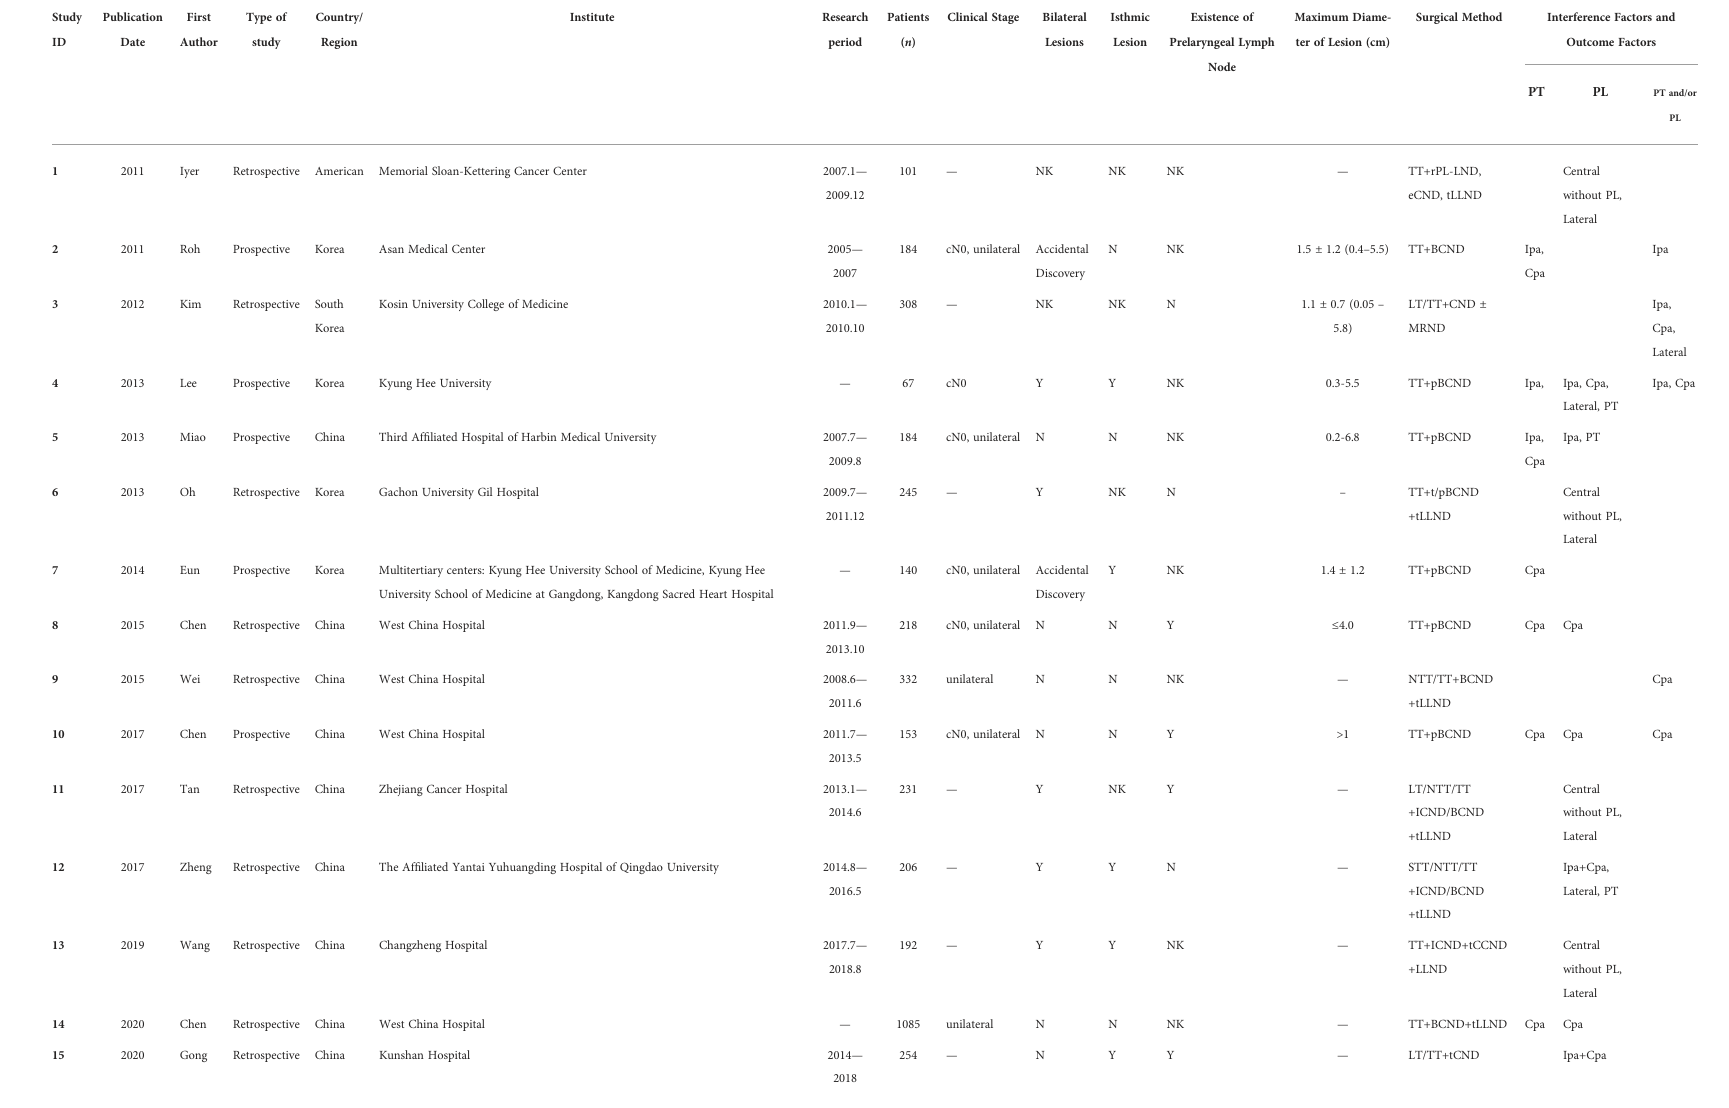
TABLE 1 The characteristics of included